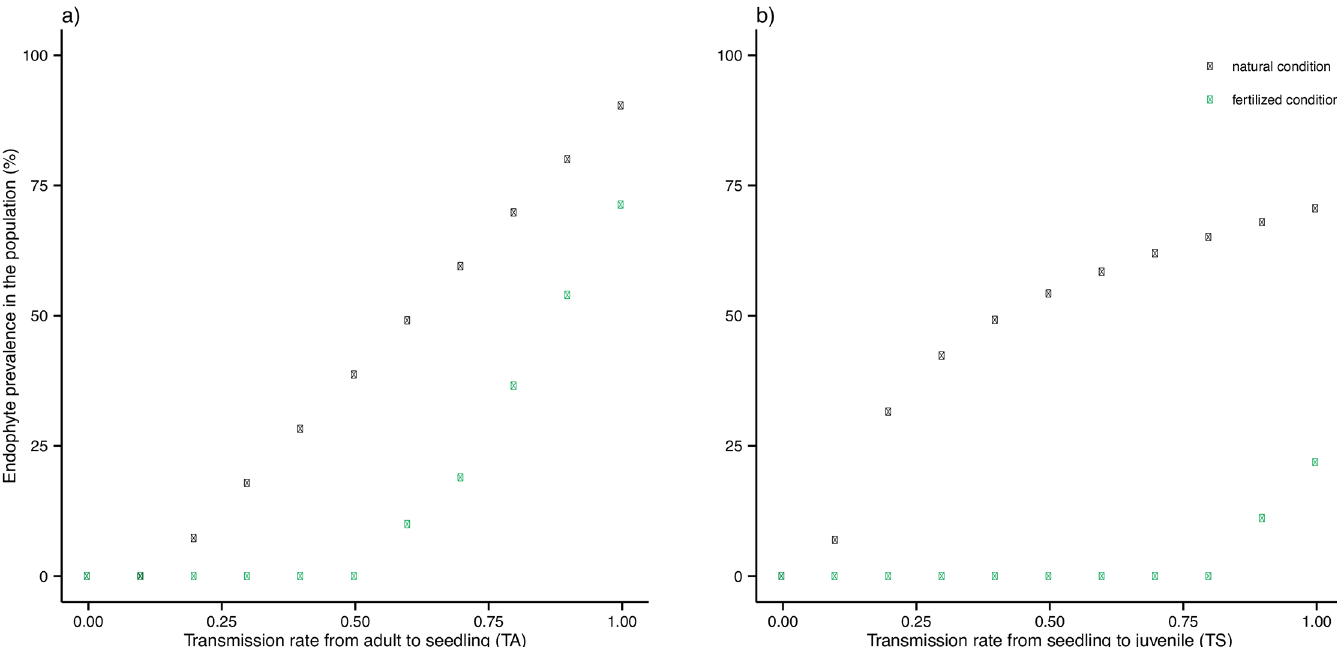
Fig 4. Endophyte prevalence (%) in host populations, as a function of edaphic resource level and variations in (a) vertical transmission rate from symbiotic adult to non-symbiotic seed (TA) with TS = 1, and (b) vertical transmission rate from symbiotic seedling to non-symbiotic juvenile 1 (TS) with TA = 1. Natural: black symbols; F-treatment: green symbols. See Fig 1B for life cycle and Table 2 for the values of the parameters used in the model.